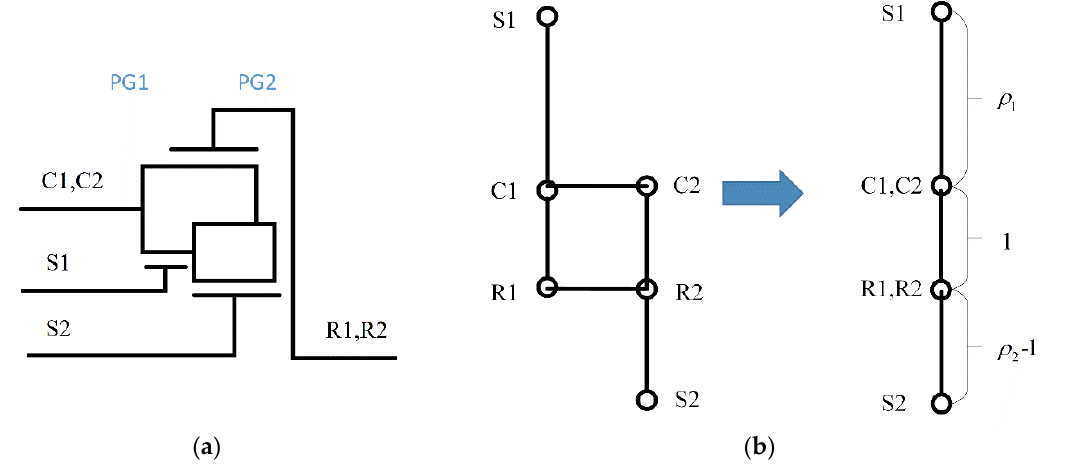
Figure 4. ( a ) Ravigneaux automotive transmission configuration; ( b ) Combined lever diagram, where Z R 1 Z R 2 ρ , ρ 2 “ 1 “ Z S 1 Z S 2